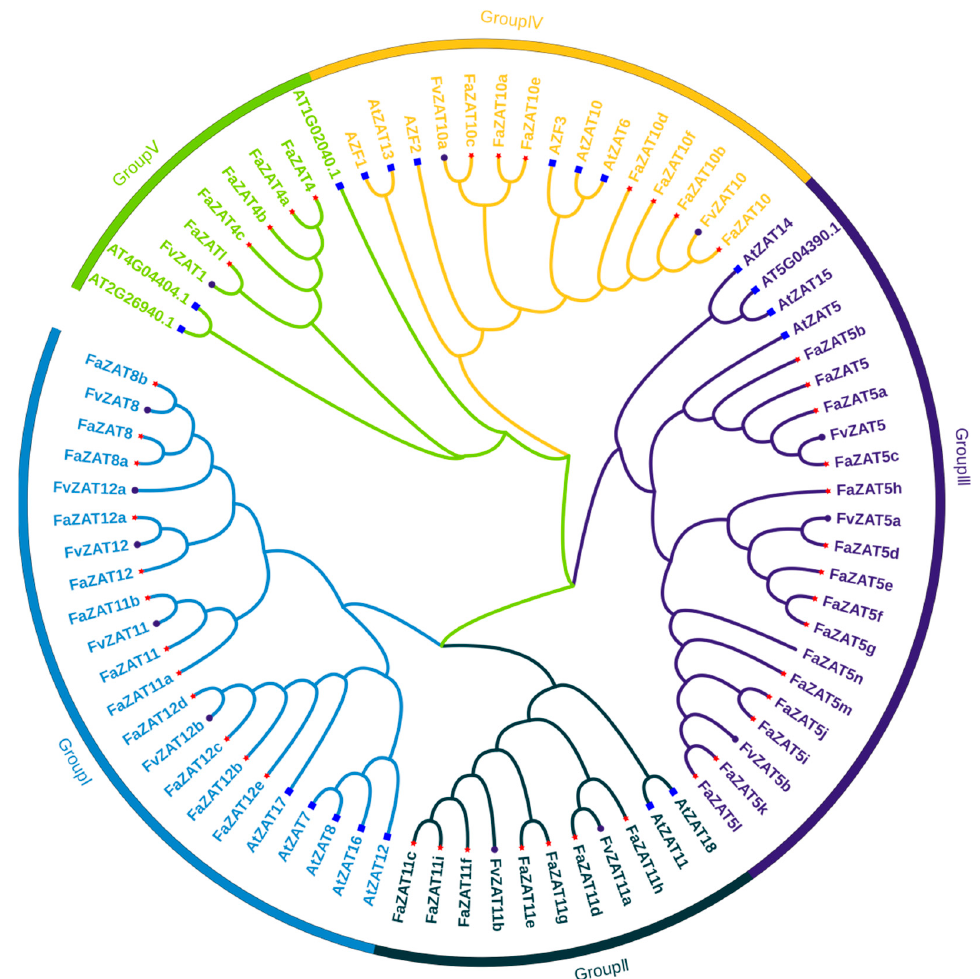
Figure 2. Unrooted phylogenetic tree of cultivated strawberry, wild strawberry, and A. thaliana C1-2i subclass members. The red asterisks represent cultivated strawberry, the purple circles represent wild strawberry, and the blue squares represent A. thaliana . The phylogenetic tree was developed on MEGA (version 7.0) using the neighborhood-joining phylogenetic method analysis. Both the bootstrap test and the approximate likelihood ratio test were set to 1000 times.